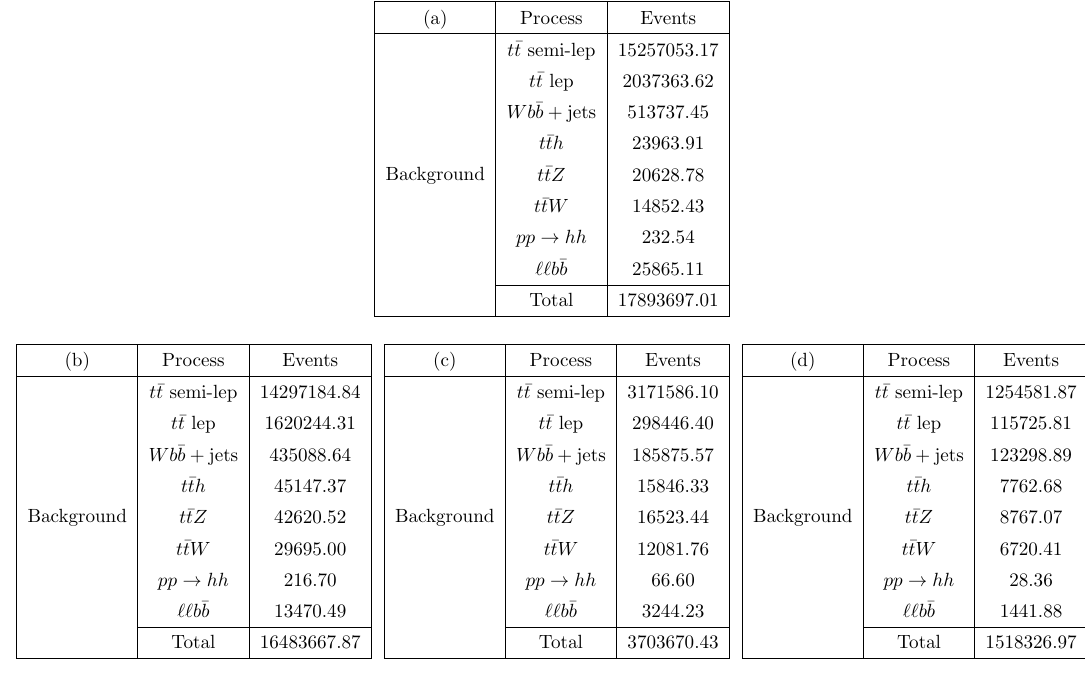
Table 16 . Respective background yields for the 1 ‘ 2 j 2 b + =E optimised for m H = ( a ) 400 GeV, ( b ) 600 GeV, ( c ) 800 GeV and ( d ) 1 TeV. The various orders of the signal and backgrounds are same as in table